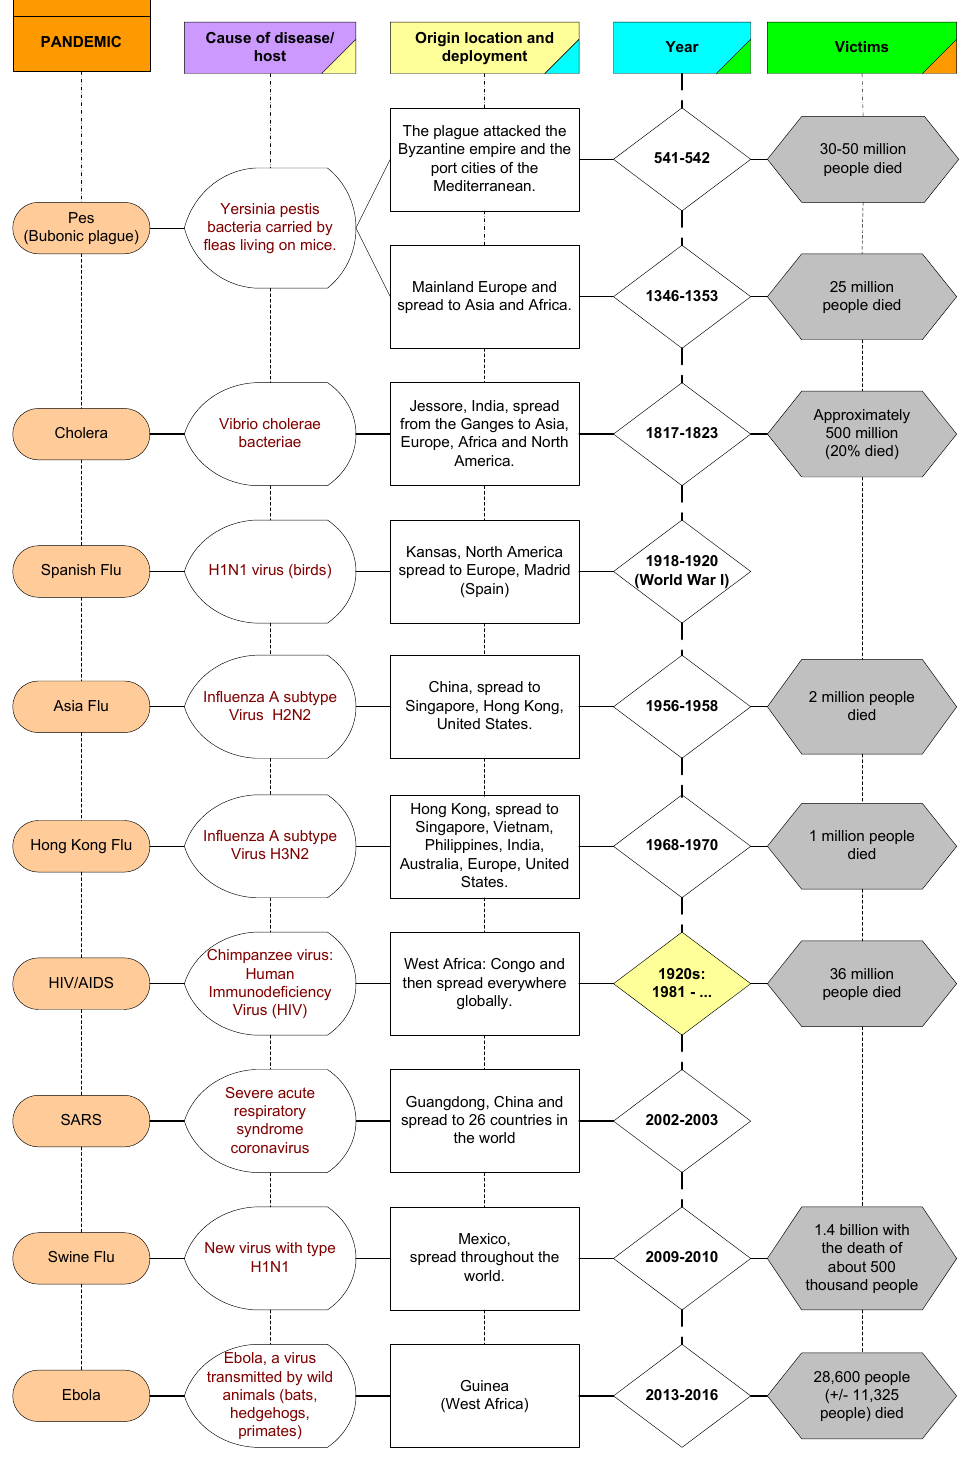
Figure 1. Pandemic events beginning the year 500 to present times in a timeline. [135–157].